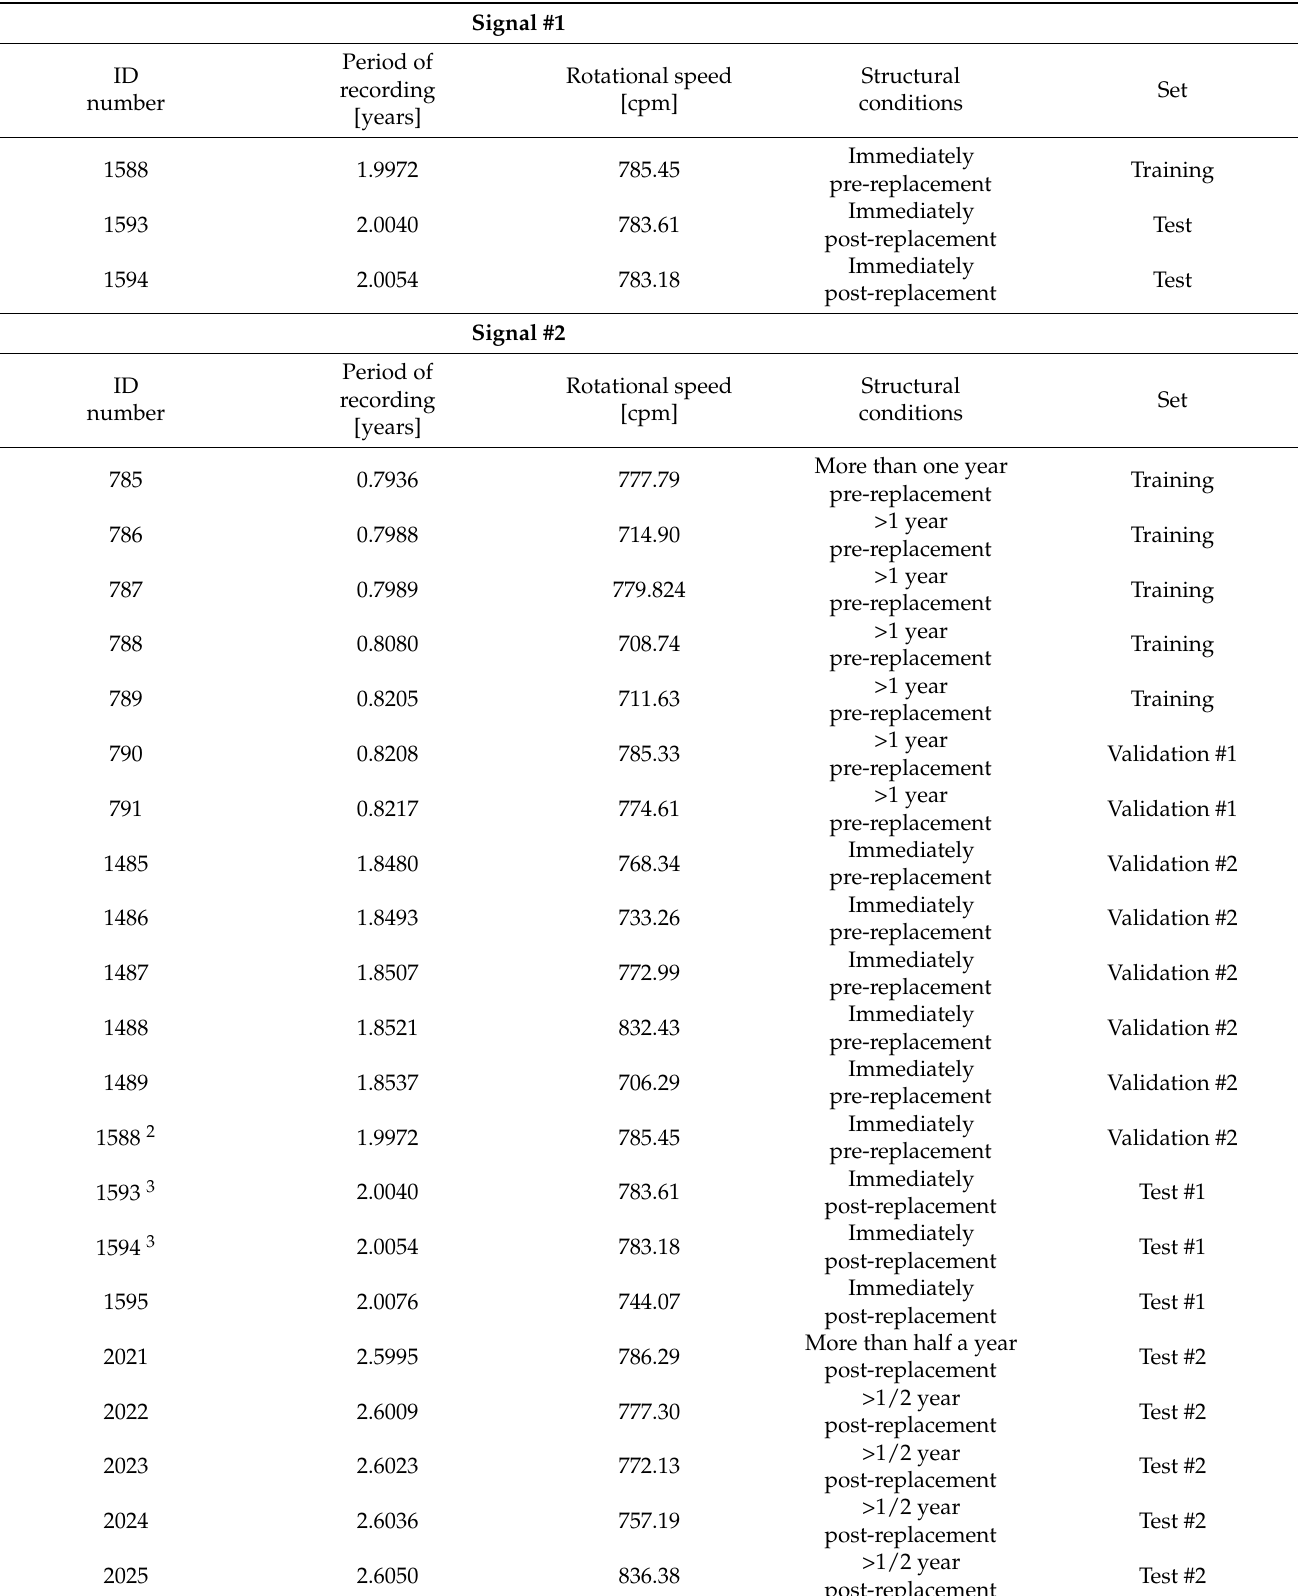
Table 1. The concatenated recordings, as reported in the experimental database 1